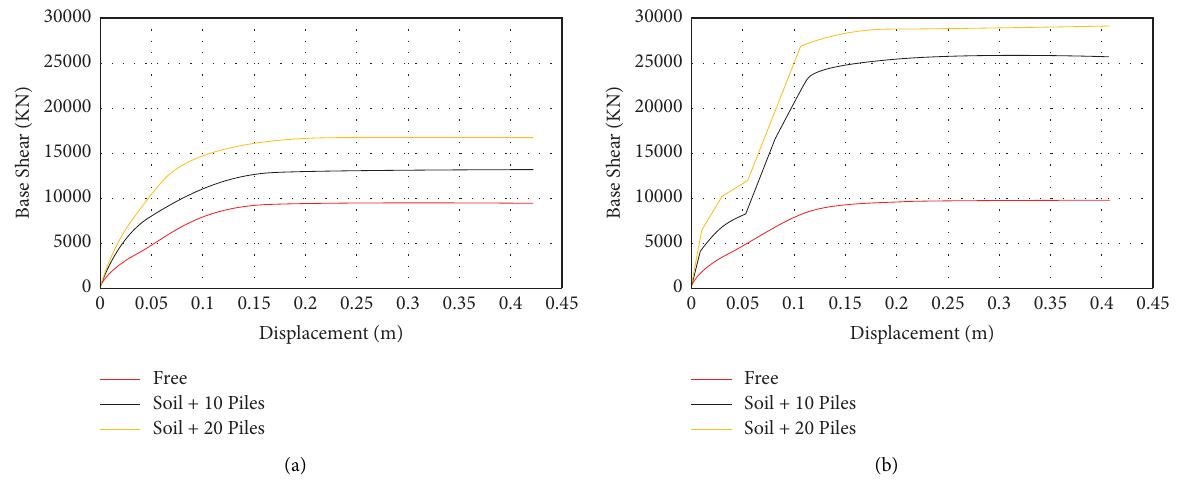
Figure 12: Pushover curves of F6, L6, and H6 bridge models in (a) longitudinal and (b) transverse directions.